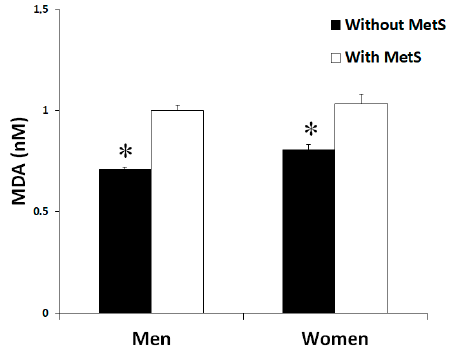
Figure 1. Malondialdehyde (MDA) levels in plasma men and women in the study, classified according to the metabolic syndrome. Significant effects of metabolic syndrome were found. Statistics: Two-way ANOVA. Results are presented as mean ± SEM. *Differences in means between participants without and with MetS.